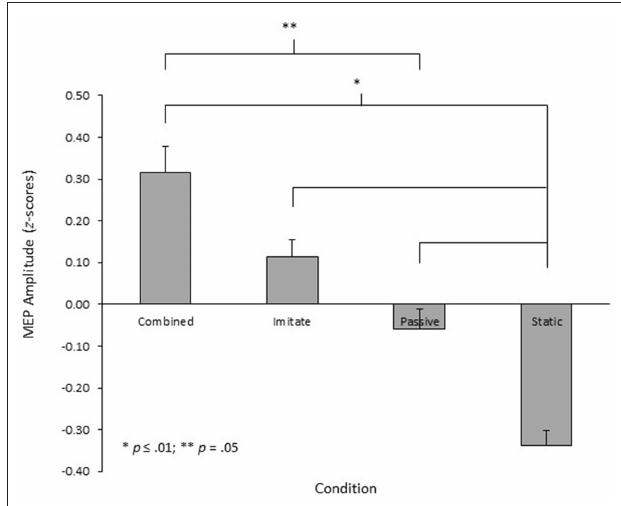
FIGURE 2 | Mean MEP amplitudes recorded from the right OP, ADM and FDI muscles in each of the four conditions of the experiment, displayed as z